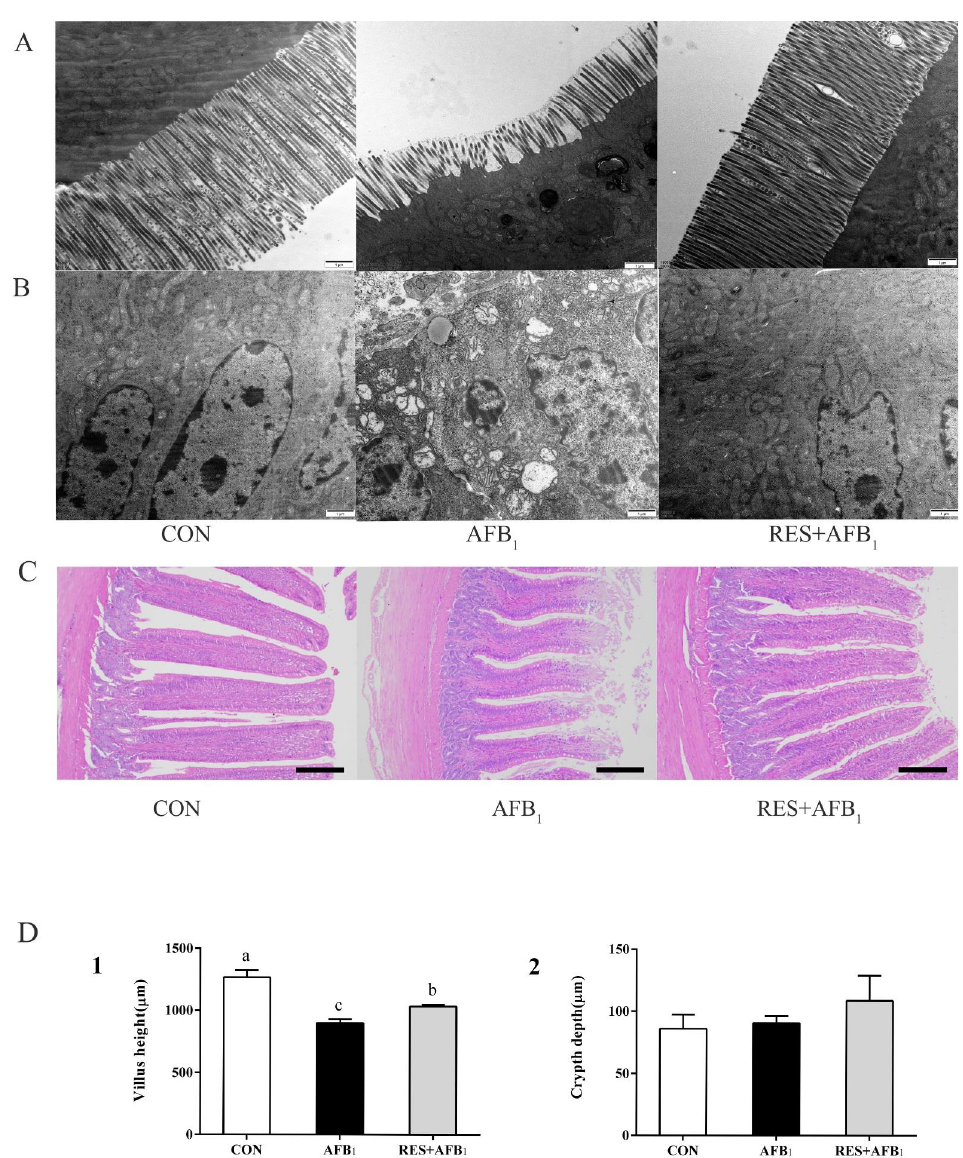
Figure 2. Effect of RES on histomorphological changes in ileum of AFB 1 -exposed duck. ( A ): Ultra- structure of microvillus, ( B ): Cell and mitochondria in ileum mucosa. Original magnification 15,000 × ; scale bars, 1.0 µ m). White arrowhead indicates the reduction in the micro villus height, and black arrowheads indicate vacuolization of mitochondria. ( C ): Representative photomicrographs of villi in ileum stained with hematoxylin-eosin (magnification, 200 × ; scale bars, 200 µ m). Black arrowhead indicates epithelial denudation and the damaged villi structure. ( D ): (1) The villus height (2) The crypt elongation. Values are expressed as mean ± SD, n = 8. Labeled (a, b, c, a > b > c) means in a row without a common letter differ, p <